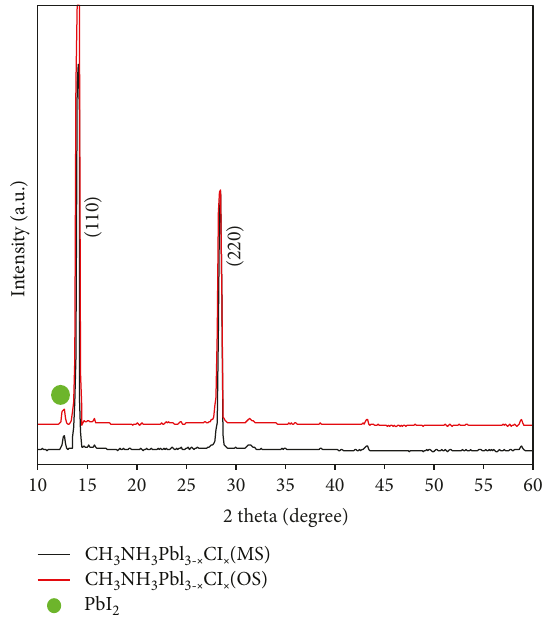
fi lms deposited on NH PbI Cl 3 3 3-X X